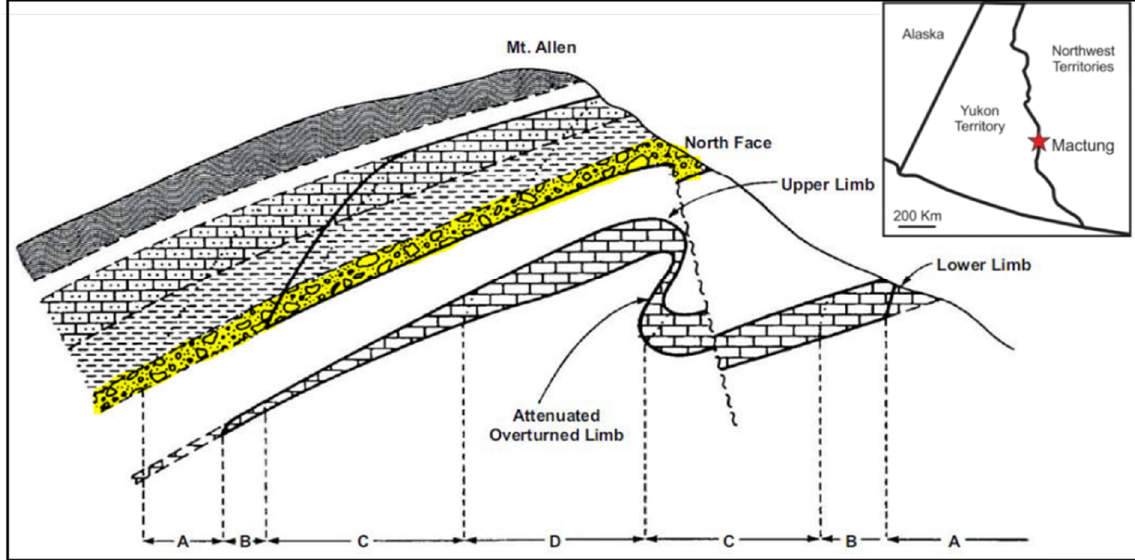
Figure 1. The stratigraphic sequence of phosphate (Unit 3D, highlighted) on the N-S cross section of the Mactung skarn deposit. Figure was modified from [13].